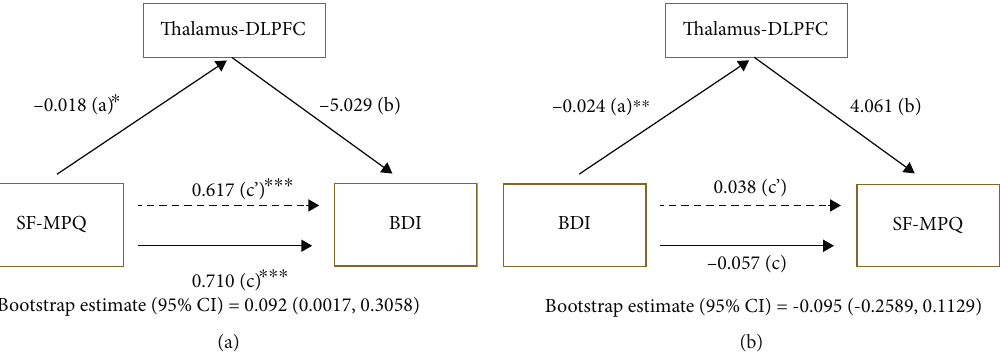
Figure 4: Resting-state functional connectivity of the thalamus and correlations between thalamus-based functional connectivity and SF- MPQ as well as BDI ratings. (a) Thalamus showed increased resting-state functional connectivity with the DLPFC, ACC, PCC, and insula in LDH patients than in HCs. (b) For LDH patients, resting-state functional connectivity between thalamus and DLPFC was negatively correlated with SF-MPQ and BDI ratings, and resting-state functional connectivity between thalamus and PCC was negatively correlated with BDI, but not with SF-MPQ ratings. DLPFC: dorsolateral prefrontal cortex; ACC: anterior cingulate cortex; PCC: posterior cingulate cortex; SF-MPQ: short form of the McGill Pain Questionnaire; BDI: Beck-Depression Inventory.